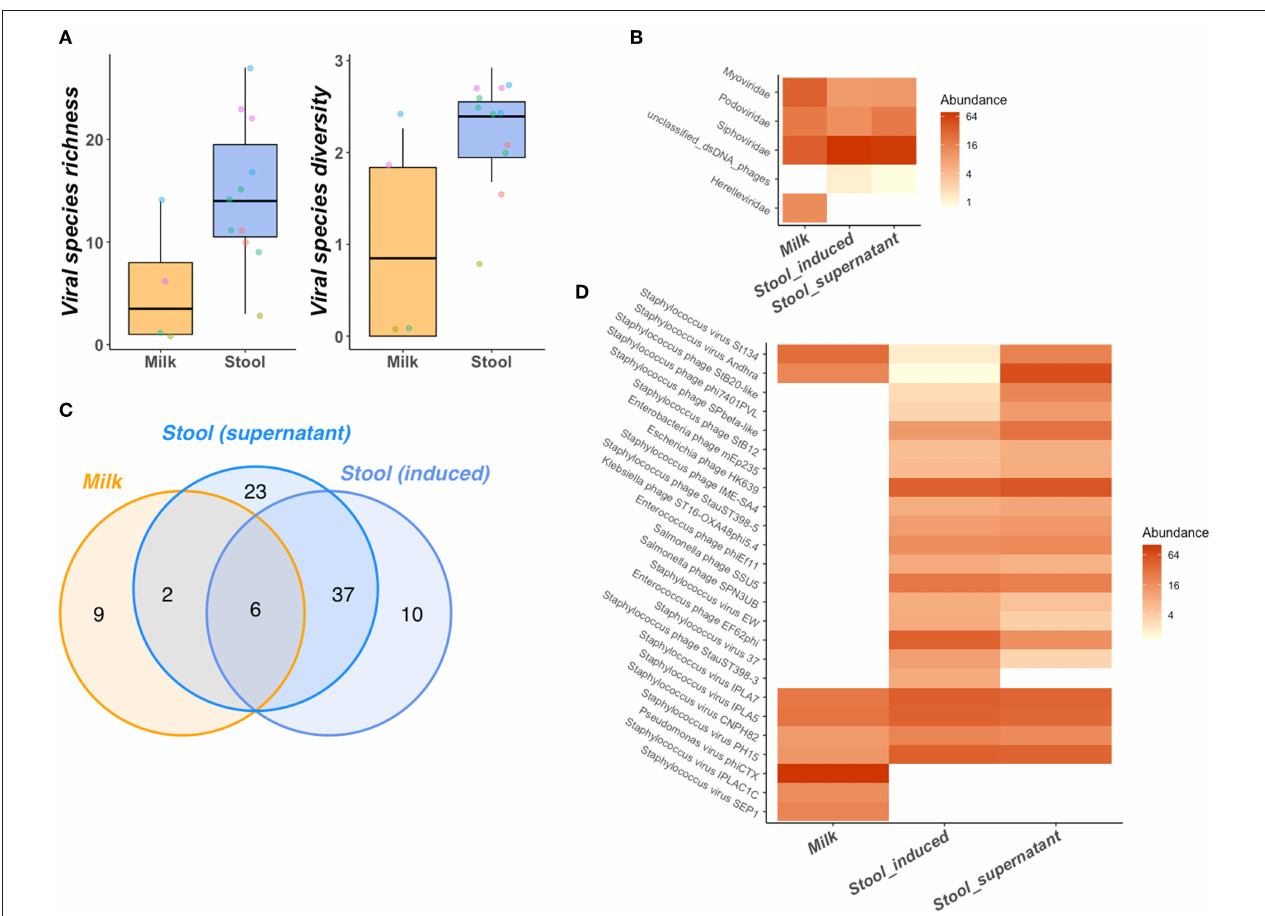
FIGURE 5 | Bacteriophage community of mother-infant pair BM and stool samples. BM has lower species richness and diversity than stool (A) despite links between BM and neonatal stool richness and diversity as illustrated points, colored by mother-infant pair. Several bacteriophage taxonomic features are shared between BM and stool samples at the family level (B) . Bacteriophage species composition of BM and neonatal stool is illustrated across all species observed via venn diagram (C) and in more detail as a heatmap containing only the top 25 most abundant & prevalent bacteriophage species (D) . Greater relative abundance of species/families in heatmaps (B,D) is represented by greater color intensity [transformed on a log(2) scale].